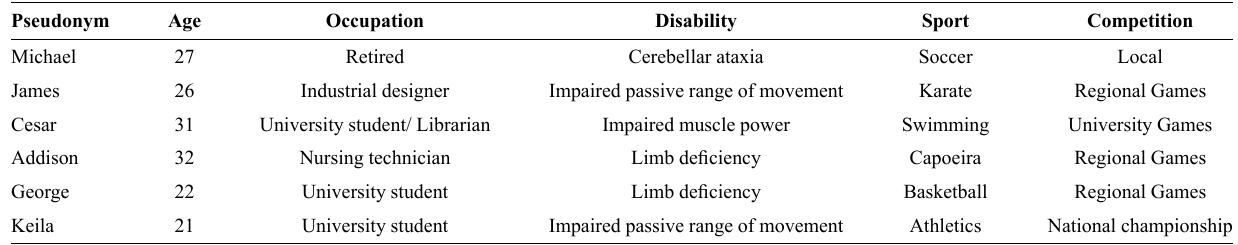
Table 1 - Interviewee